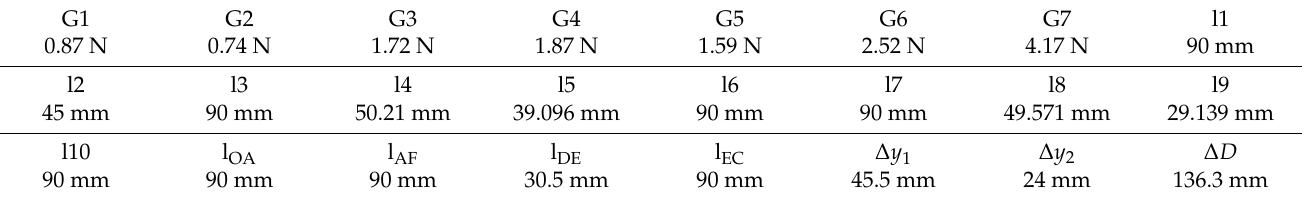
Table 1. Parameters of static model.